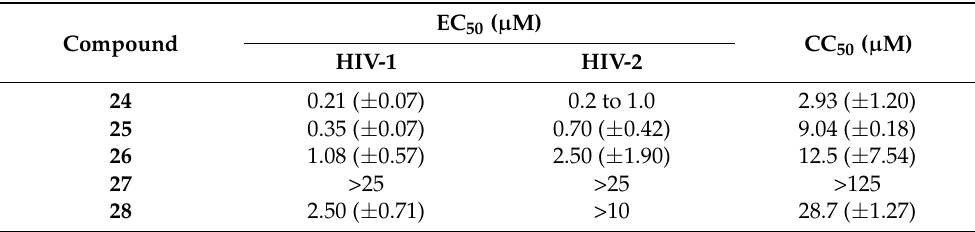
Figure 9. Structure diagram of fullerene pyrrolidine derivatives ( 24 – 28 ). Table 2. Anti-HIV activity and cytostatic activity of compounds ( 24 – 28 ) in CEM cell